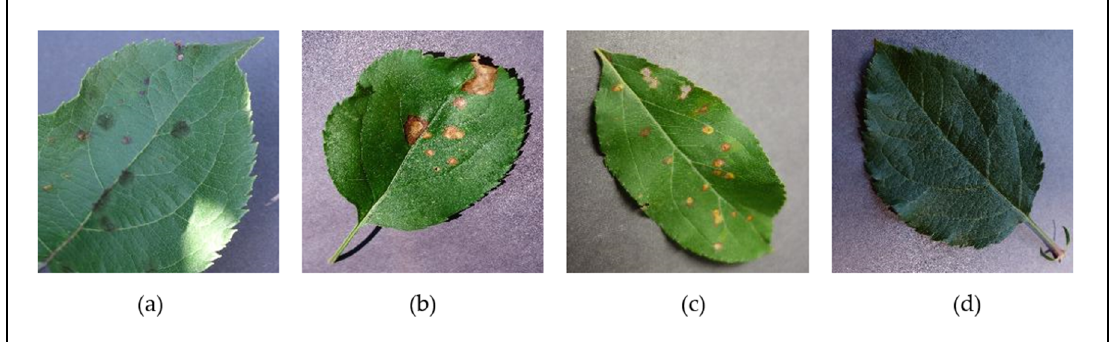
Figure 2. Examples of leaves from the different classes supported for the Apple species in the PlantVillage dataset—( a ) Apple Scab ; ( b ) Apple Black Rust ; ( c ) Apple Cedar Rot ; ( d ) Apple Healthy .